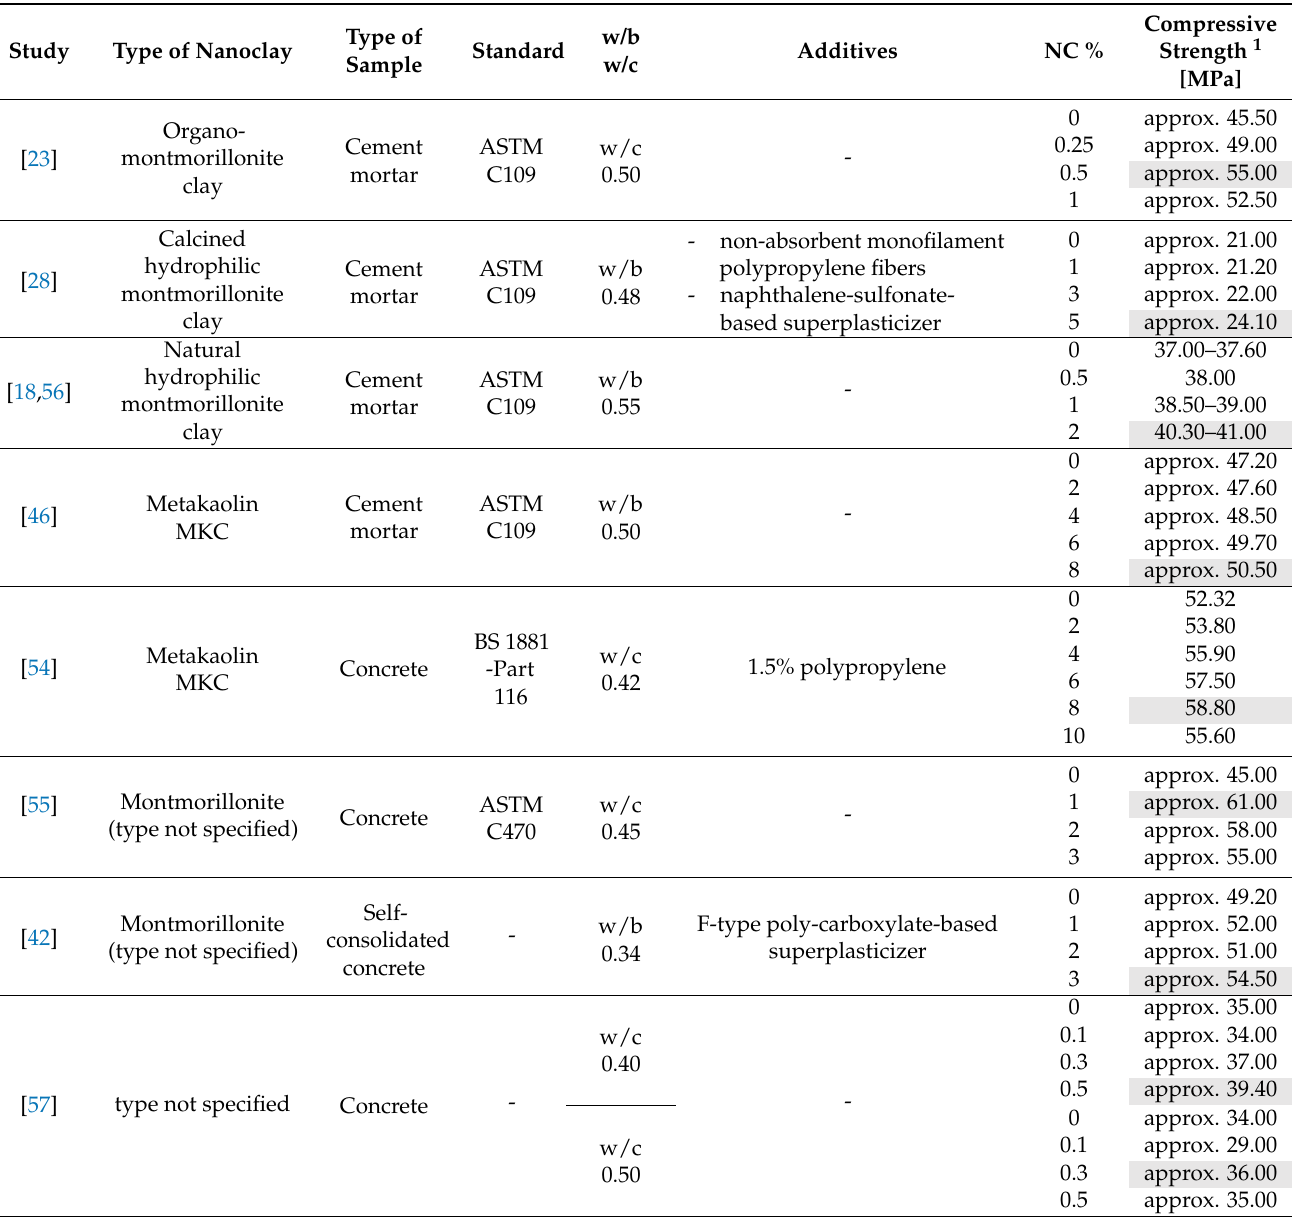
Table 3. Compressive strength values for nanoclay—mortar/concrete specimens at room